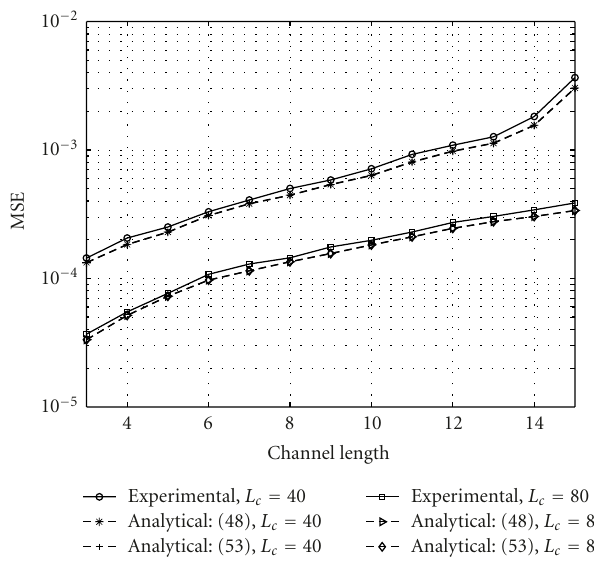
Figure 9: MSEs of the estimated channel versus L for L c = 40 and L c = 80. The BP